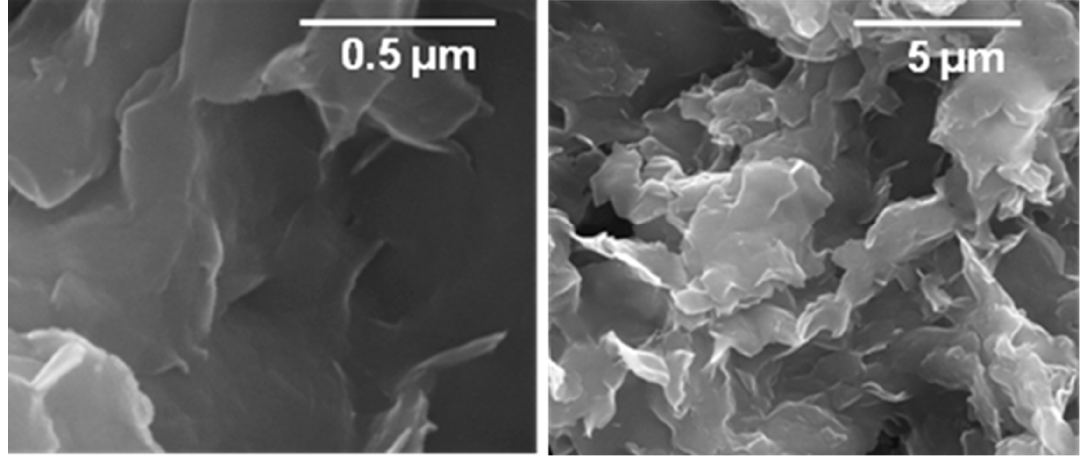
Figure 2. SEM images of the GCE/COOH-PPy/NH 2 -NCY at different magnifications.